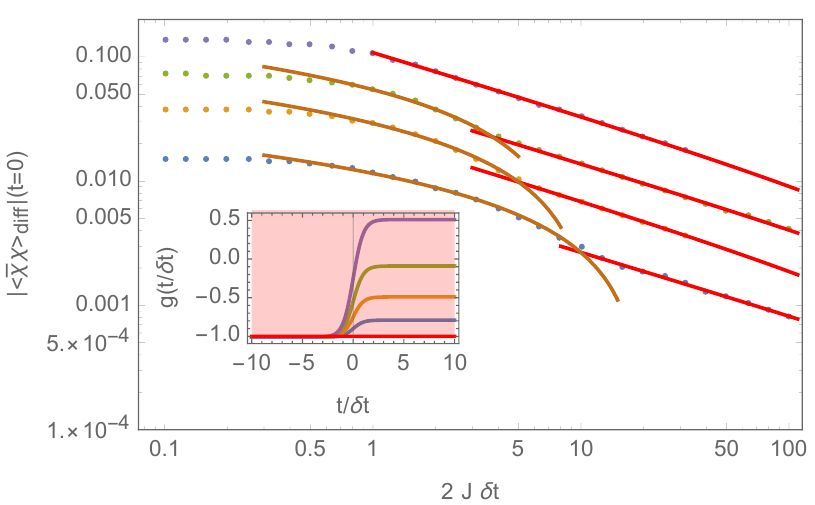
Figure 8 . Plot of h (cid:22) (cid:31)(cid:31) i di(cid:11) as a function of 2 J(cid:14)t for the large-amplitude gapped-to-gapless quenches shown in the inset. The initial distance to the critical region is 0.01. The brown and red curves are the best (cid:12)ts in the fast and slow quench regimes, respectively. In all cases they correspond to (cid:12)ts by P 1 + Q 1 log(2 J(cid:14)t ) for the fast and P 2 + Q 2 (2 J(cid:14)t ) (cid:0) 1 = 2 for the slow regime. P 1 = 0 : 00385 (blue), 0 : 0119 (yellow), 0 : 0240 (green); Q 1 = (cid:0) 0 : 0115 (blue), (cid:0) 0 : 0291 (yellow), (cid:0) 0 : 0544 (green); P 2 = (cid:0) 0 : 00857 (blue), (cid:0) 0 : 0229 (yellow), (cid:0) 0 : 0448 (green), (cid:0) 0 : 110 (violet); Q 2 = 0 : 0000391(blue), 0 : 000421 (yellow), 0 : 000443 (green), 0 : 00194 (violet). The crossover between fast and slow regimes happens at a J(cid:14)t that is inversely proportional to the amplitude of the quench, making the fast regime to e(cid:11)ectively disappear when the amplitude is large enough (like for the violet